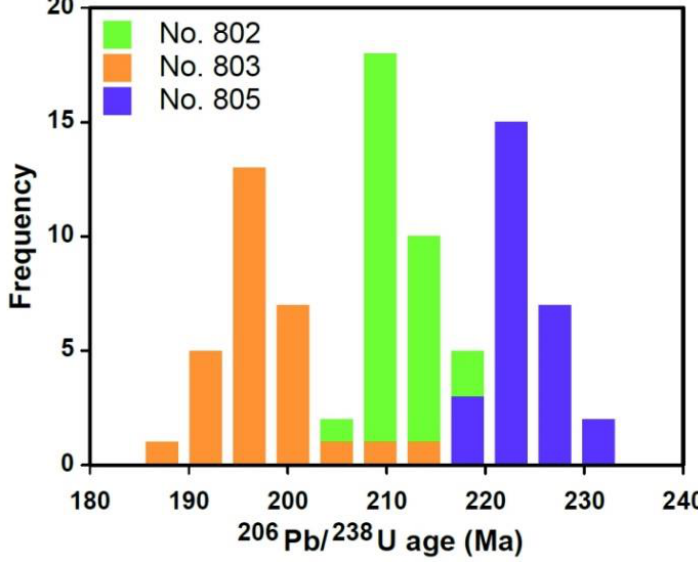
Figure 7. Histograms showing 206 Pb/ 238 U age ranges for the studied pegmatites at Kalu’an.